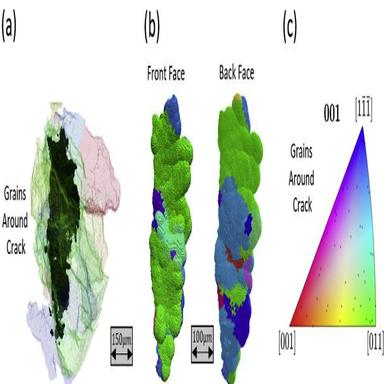
(a) Grains of interest surrounding the crack path extracted after registration between NF-HEDM and m-CT. (b) Grains adjacent to the crack, as shown from the front and back faces (see view P of (d)). (c) Stereographic triangle for reference to the colors of the grains and the orientation distribution of the grains adjacent to the crack. (For interpretation of the references to color in this figure legend, the reader is referred to the Web version of this article.)